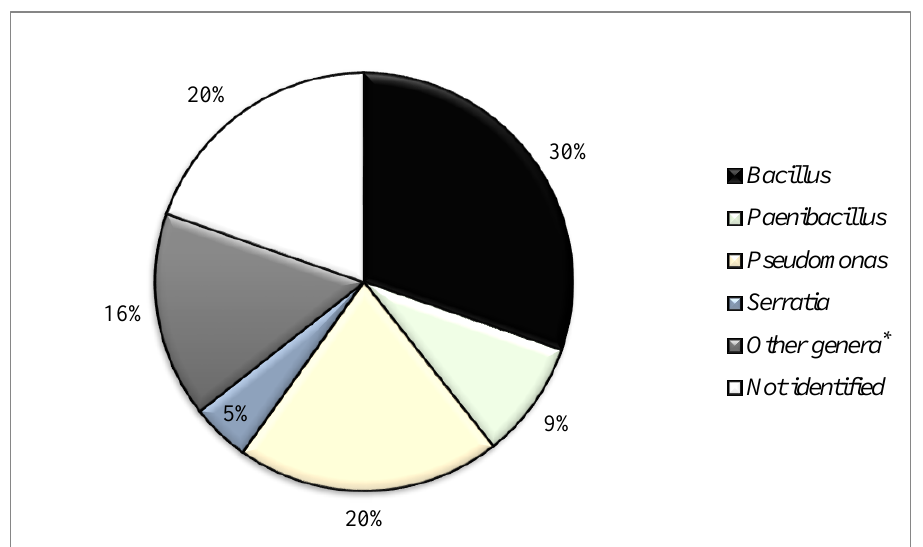
Figure 1. Diversity at genus level of the antimicrobial-producing bacteria isolated from soil samples in the first initial screening. * Other genera: include isolates of genera with less than six representants; see Table 1.